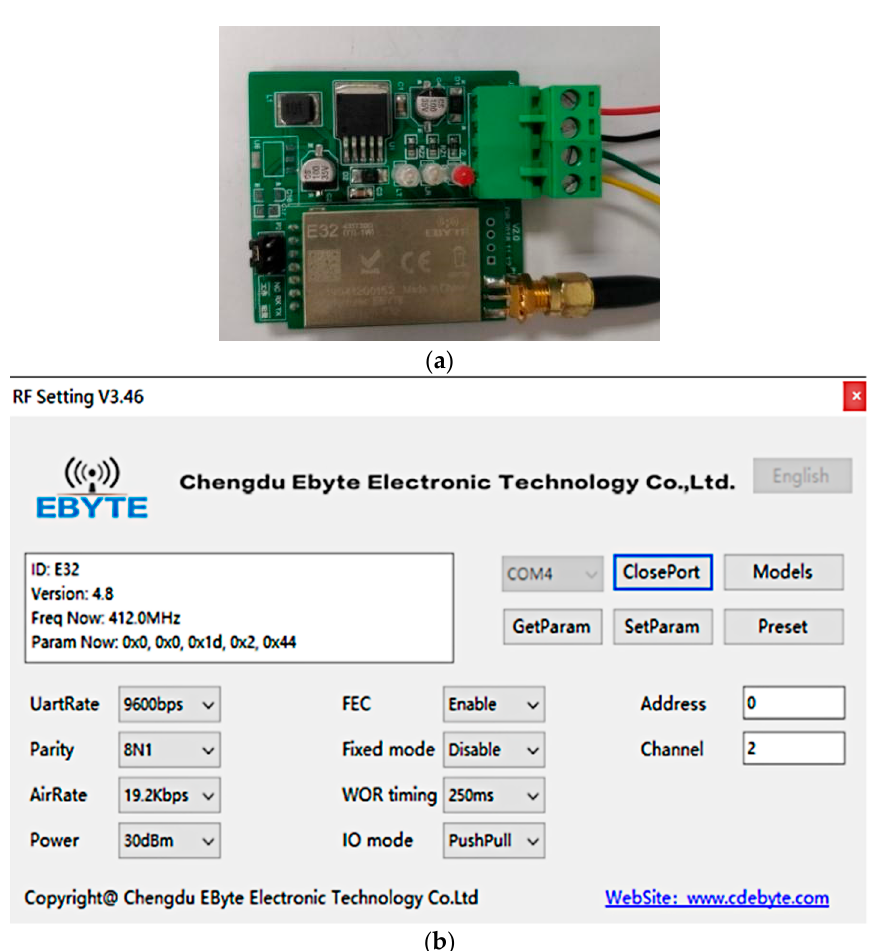
Figure 4. LoRa module: ( a ) LoRa hardware; ( b ) configuration software *. * location: http://www.